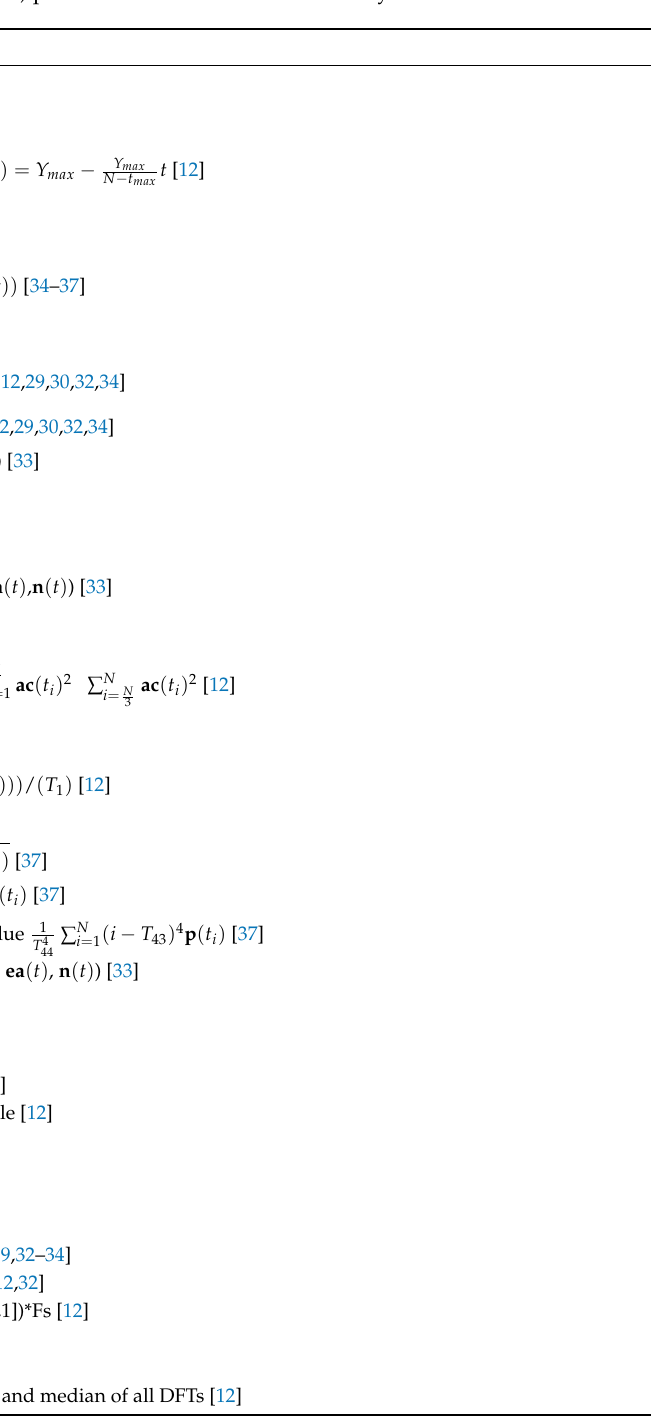
Table A1. List of features drawn from the literature: temporal s ( t ) , power signal p ( t ) , envelope e ( t ) , auto correlation function ac ( t ) , spectral f ( v ) , cepstrum domain ce ( v ) , template rockfall r ( t ) , slide quake q ( t ) , earthquake ea ( t ) , noise n ( t ) , and envelope es ( t ) with (5–10 Hz), (10–50 Hz), (5–70